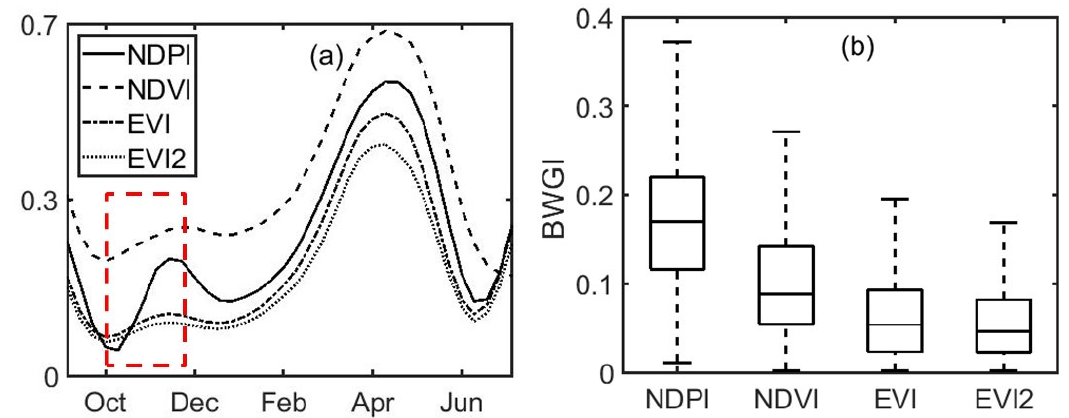
Figure 13. Comparison of four vegetation index (VI) curves of winter wheat in the period of before-winter growth. ( a ) Average VI curves of visually interpreted winter wheat pixels. ( b ) before-winter growth index (BWGI) statistics of the four VIs. The red line and blue box represent the median value and 25th–75th percentiles. The whisker covers the data values within 3